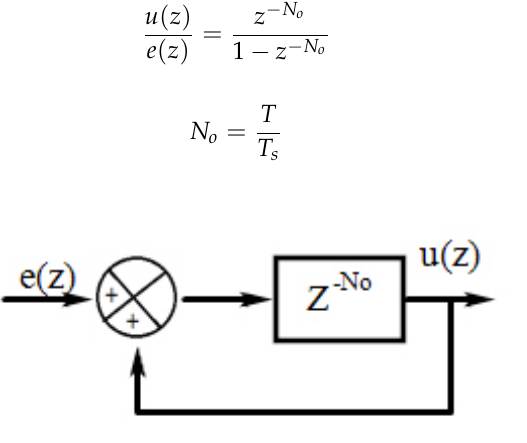
Figure 10. Memory loop in discrete